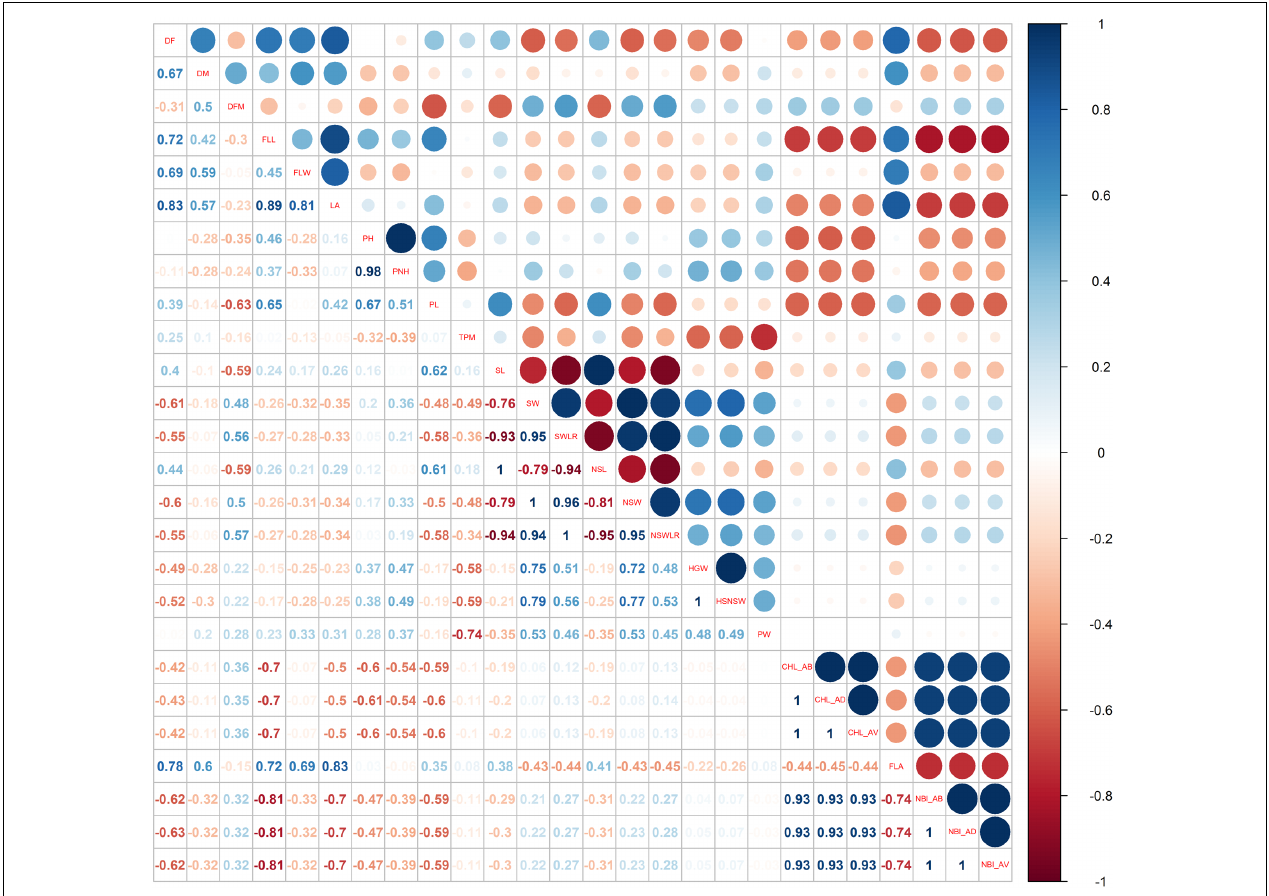
FIGURE 4 | Pearson correlations among the phenotypic traits used for the genome-wide association study recorded in the PF cultivation system.